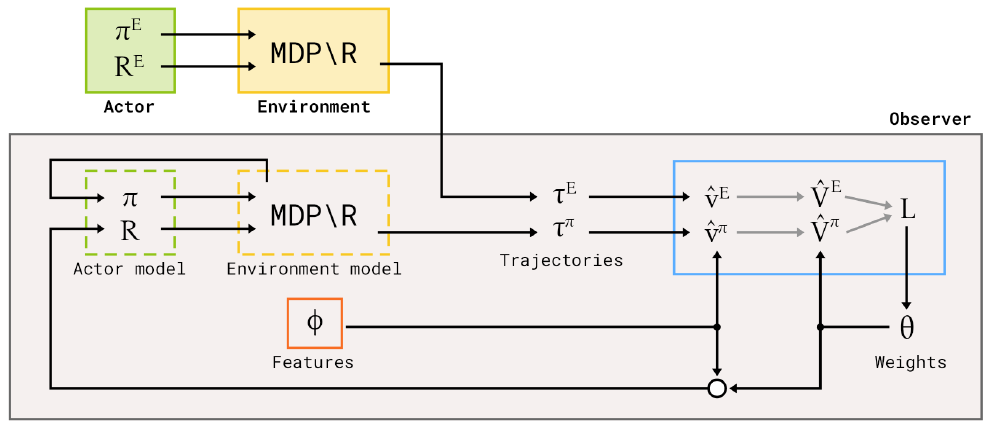
Figure 1. Diagram of the max-margin IRL algorithm (see Algorithms 1 and 2). Given trajectories τ E , the observer constructs a model of the actor comprising a policy π and reward function R (dashed green), employing a model of the environment (i.e., a model of the MDP \ R, dashed yellow, which is usually assumed to be a priori known by the observer and equal to the actual environment, yellow) to generate candidate trajectories τ π . Both trajectories are compared (blue) with the aid of features φ (orange) that are intrinsic to the observer to update the weights θ . The weights characterise the reward function in conjunction with the features. Iteratively repeating this process yields a suitable reward function.